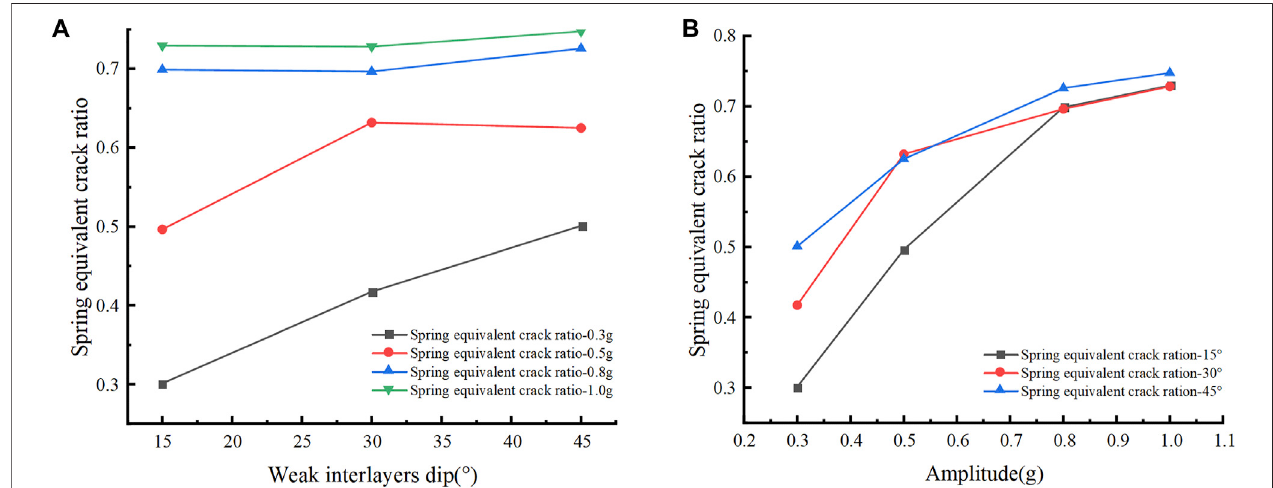
FIGURE 12 | Variation of fi nal spring equivalent crack ratio (A) with weak interlayers dips, (B) with amplitudes.